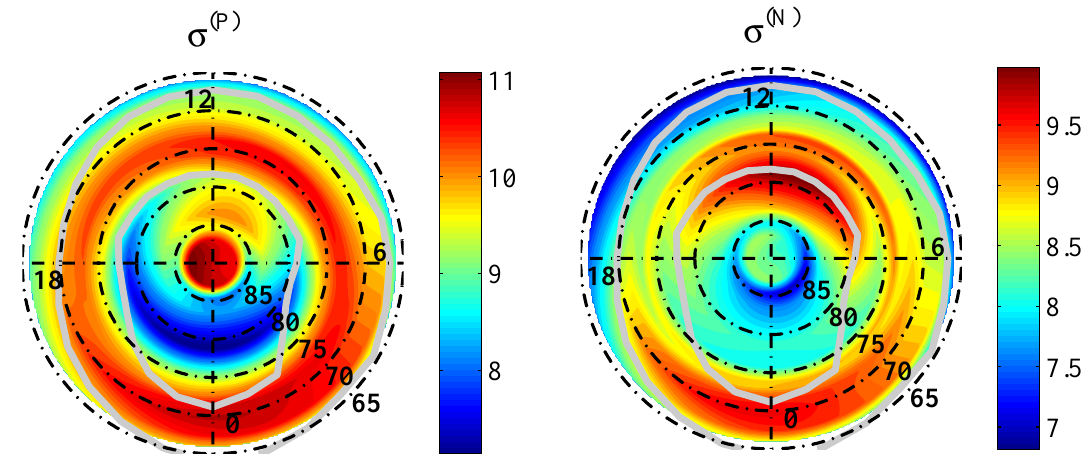
Fig. 5. 2-D distribution of σ calculated according to Eq. (6) with K = 2 in 8 -MLT coordinates for P-component (left) and N-component (right). Two-year averaged positions of auroral boundaries are shown with white thick grey lines.